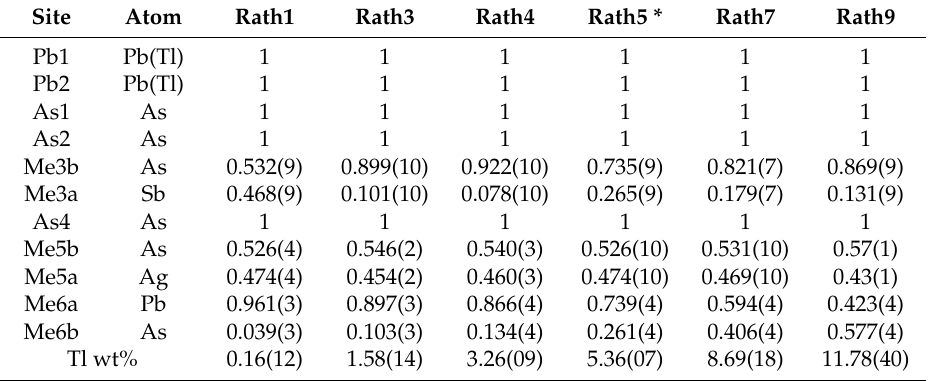
Table 8. Comparison of site occupancies and measured Tl contents of the studied rathite